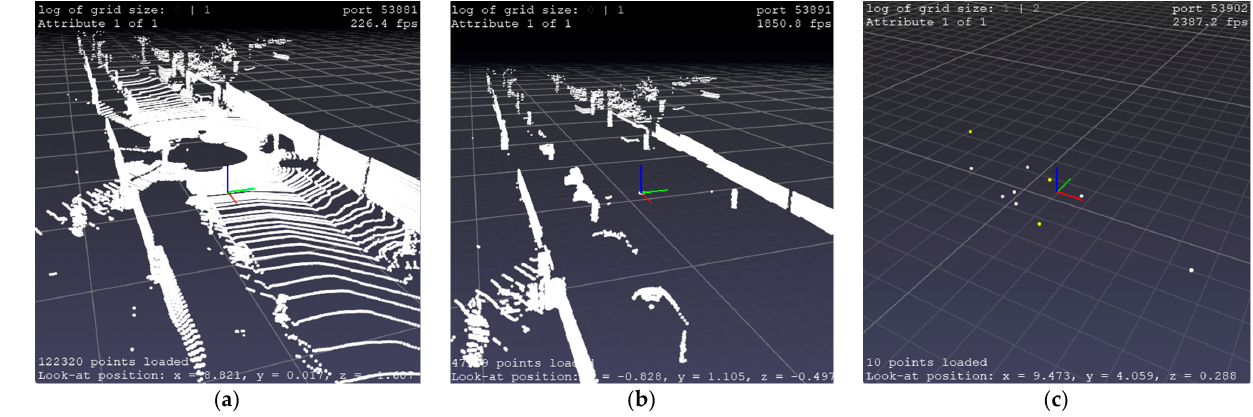
Figure 2. Illustration of the feature extraction. ( a ) 3D LiDAR points scan; ( b ) Removing the ground plan Scene; ( c ) Features extraction process (Zoomed in).